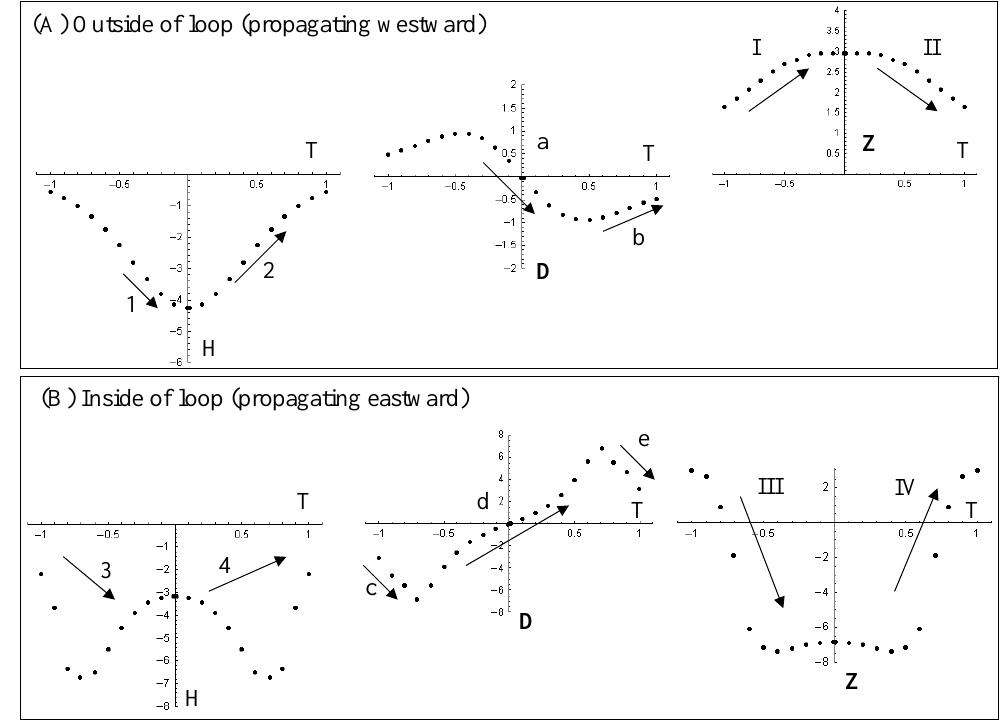
Figure 14. Calculated magnetic fields of H , D , and Z components on the ground produced by the loop current propagating at ionospheric altitudes (100km). The amplitudes are relative. The imaging currents of the ground are not included. The radius of the ionospheric current is assumed to be 500km. In (A) , the ground station is located at 600km north of the center of the loop; (B) represents the ground station located 350km north of the center of the loop. The loop current approached from the east for (A) and from the west for (B) ( T = − 1), passed overhead ( T = 0), and moved to the west or to the east of the current loop ( T = 1). Arrows in the plots (1 to 4 for H , a to e for D , and I to IV for Z ) correspond to the field line changes labeled in Fig.